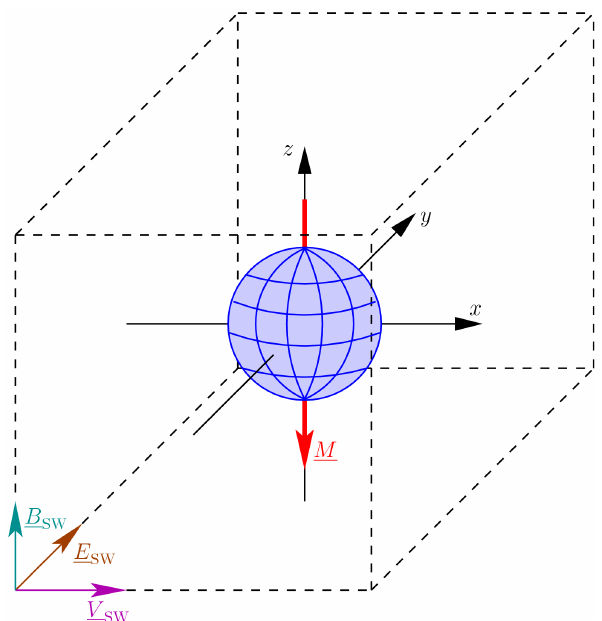
Fig. 3. 3-D simulation geometry – Antiparallel orientation of mag- netic moment M and solar wind magnetic field B SW . The center of the obstacle coincides with the origin of the Cartesian coordinate system. The undisturbed plasma flow and the interplanetary mag- netic field point in ( + x) and in ( + z) direction, respectively. Hence, the convective electric field points in ( + y)